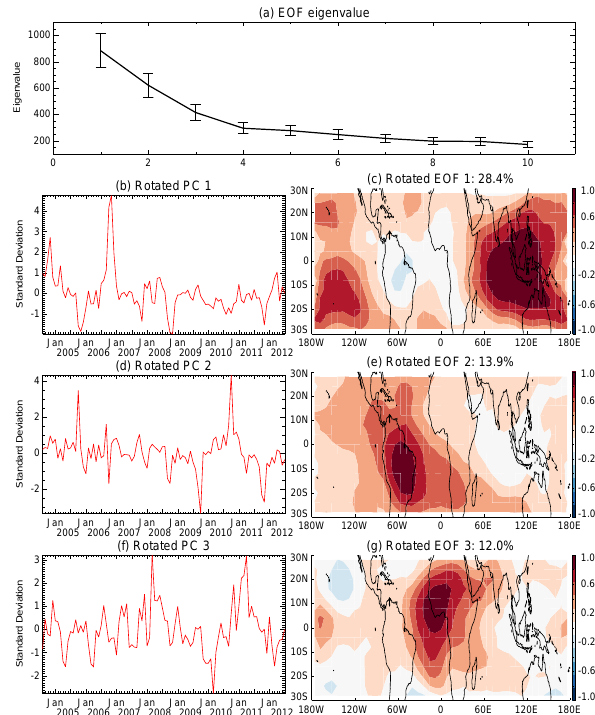
Fig. 1. REOF analysis results of monthly anomalies of CO at 147hPa for the period of August 2004–July 2012: (a) the first 10 EOF eigenvalues, (b) the first rotated principle component, (c) spa- tial pattern of the first REOF mode, (d) the second rotated princi- ple component, (e) spatial pattern of the second REOF mode, (f) the third rotated principle component, and (g) spatial pattern of the third REOF mode. The error bars in (a) represent the uncertainties of each eigenvalue. The spatial patterns in (c) , (e) and (g) are shown as homogeneous correlation